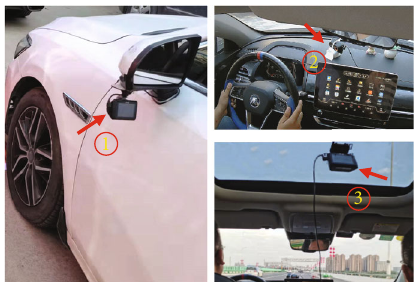
Figure 2: Installation location of three video